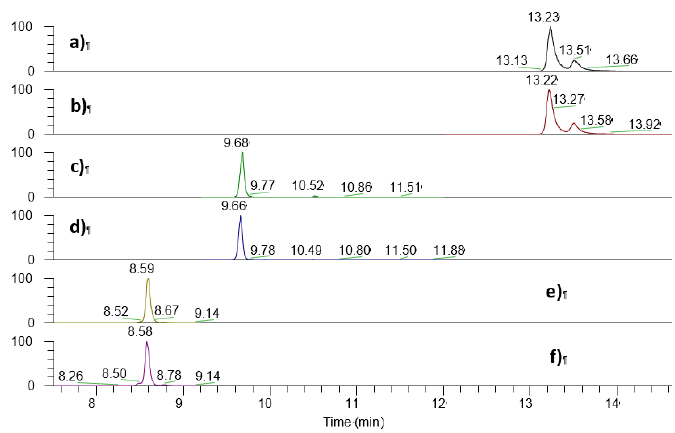
Figure 1. Extracted Ion Chromatography of standards mixed solution derivatized with Amplifex reagent. ( a ) m / z 657.43 extracted from the MS / MS spectrum of the m / z 716.50 ion of cholecalciferol, ( b ) m / z 660.45 extracted from the MS / MS spectrum of the m / z 719.50 ion of d3-cholecalciferol, ( c ) m / z 673.43 extracted from MS / MS spectrum of the m / z 732.51 ion of 25(OH)D3, ( d ) m / z 676.45 extracted from MS / MS spectrum of the m / z 735.50 ion of d3-25(OH)D3, ( e ) m / z 689.42 extracted from MS / MS spectrum of the m / z 748.51 ion of 1,25(OH)2D3 and (f) m / z 692.44 extracted from MS / MS spectrum of the m / z 751.50 ion of d3-1,25(OH)2D3.